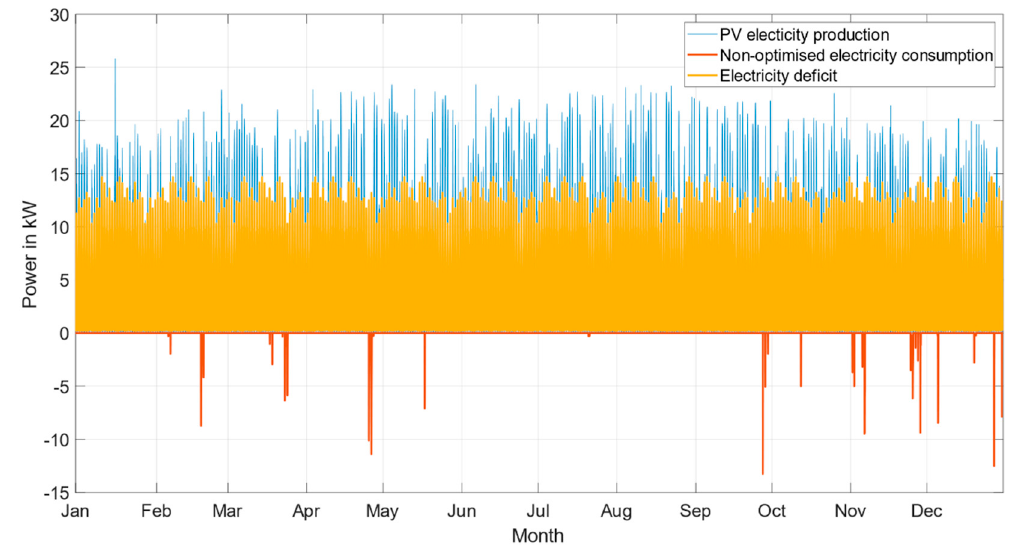
Figure 20. Annual hourly PV electricity production, demand, and deficit in kW.